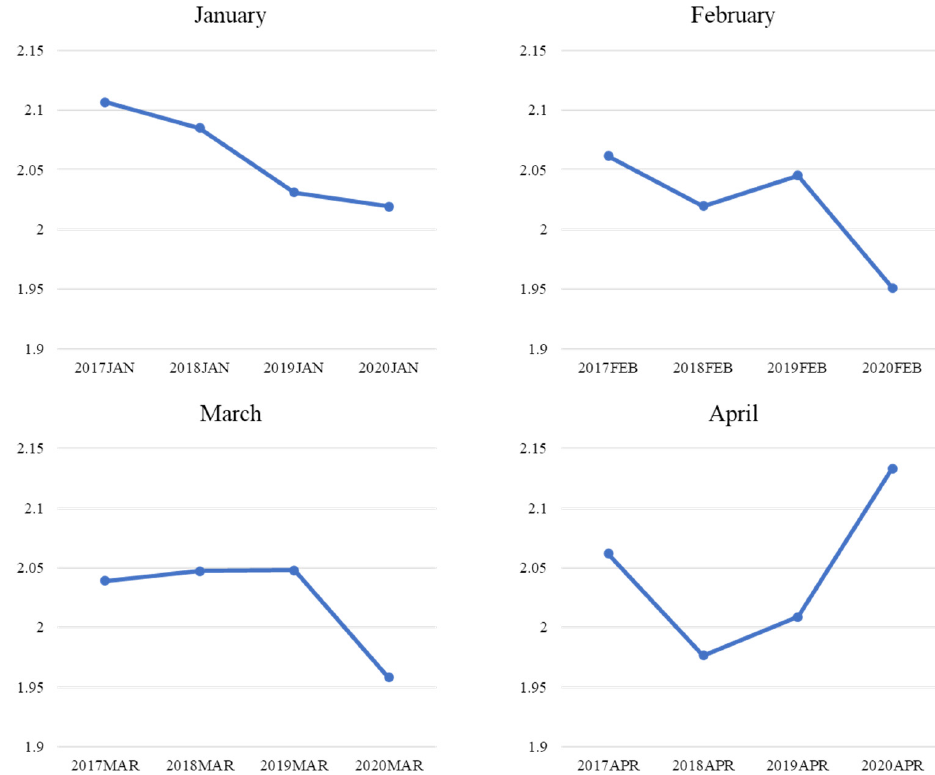
Figure 5. Mean Comparison of Negative Sentiment by Month.